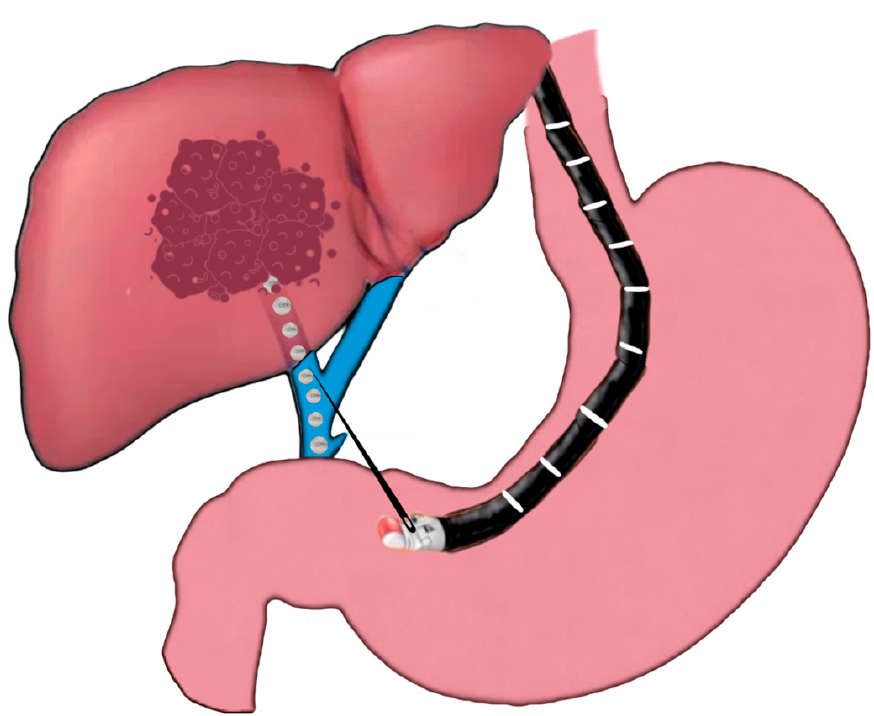
Figure 6. EUS-guided liver tumor ablation.